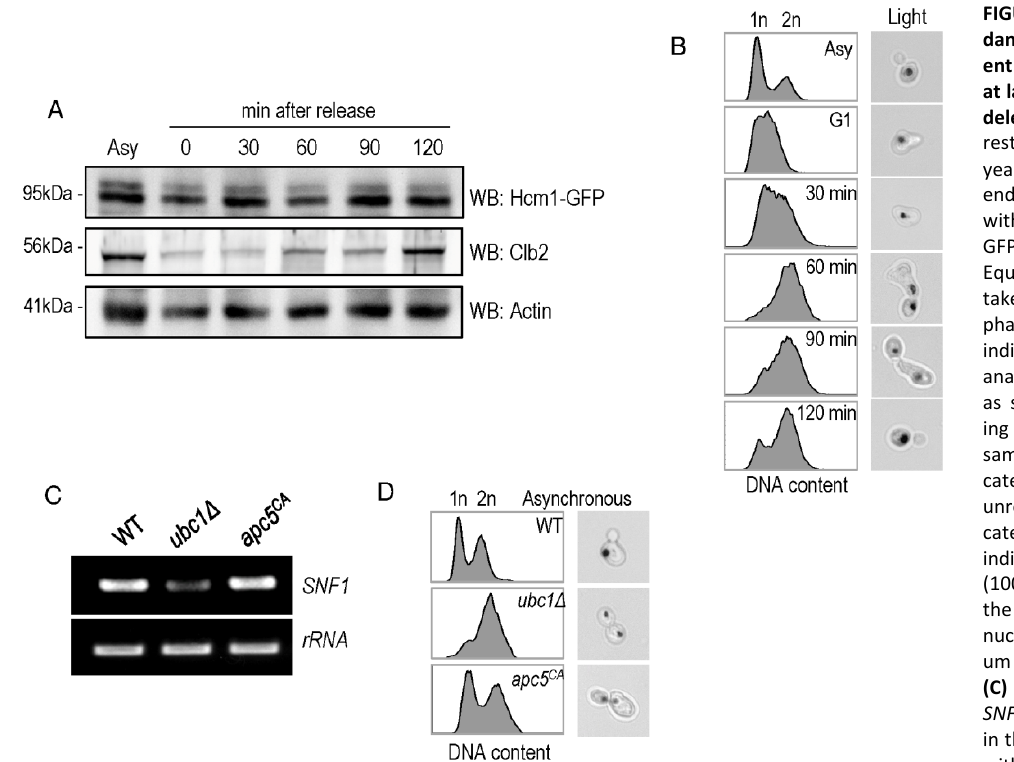
FIGURE 7: Hcm1 abun- dance is cell cycle depend- ent and cells are arrested at late M phase upon Ubc1 deletion. (A) α-factor ar- rest release of the WT yeast strain harboring an endogenous Hcm1-GFP tag, with detection of Hcm1- GFP and endogenous Clb2. Equal cell numbers were taken after release from G1 phase at the time points indicated, and Western analysis of the cell lysates as shown. (B) Correspond- ing FACS analysis of WT samples in (A) at the indi- cated time points, with unreplicated (1n) and repli- cated (2n) DNA content indicated. Light images (100x objective) indicate the cell morphology and nuclear position (propidi- um stained nucleic acid). (C) RT-PCR (26 cycles) of SNF1 and rRNA expression in the ubc1 Δ apc5 CA strains, with comparison to isogen- ic WT. (D) Flow